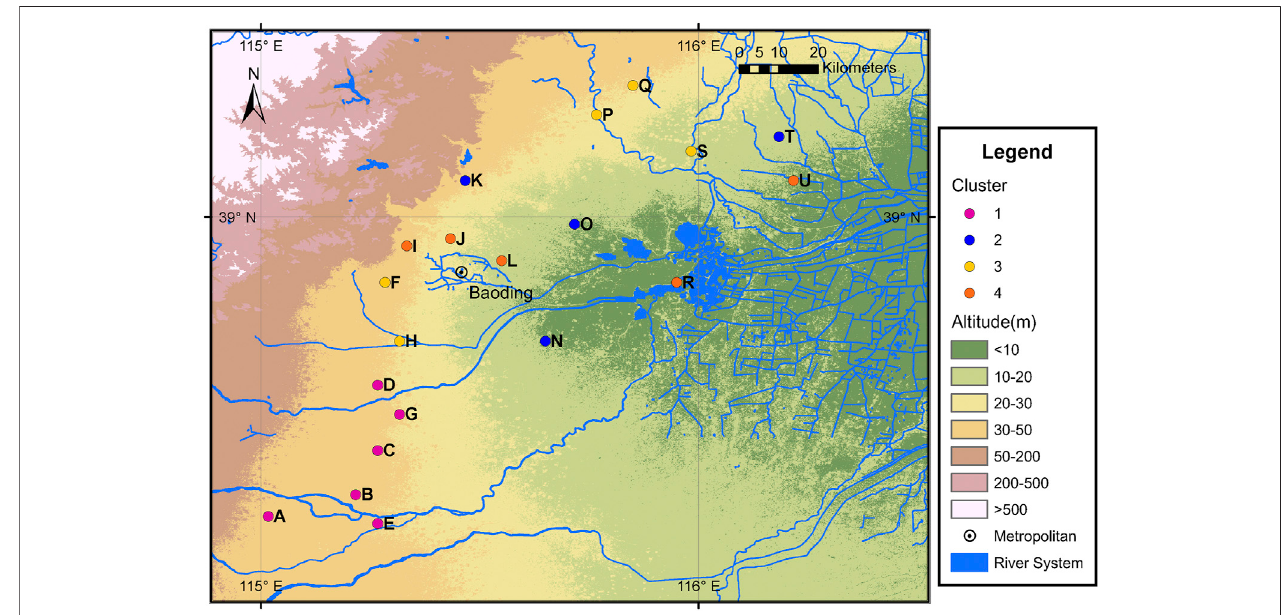
FIGURE 4 | Clustering of all